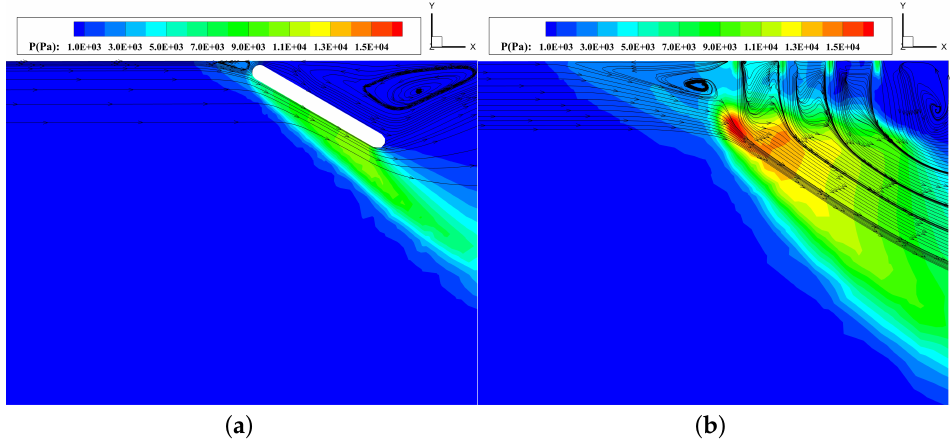
Figure 10. Spanwise section plane pressure contour and streamlines. ( a ) Case 2 ( C M = 0.004088) at Spanwise 0.112. ( b ) Case 4 ( C M = − 0.006832) at Spanwise